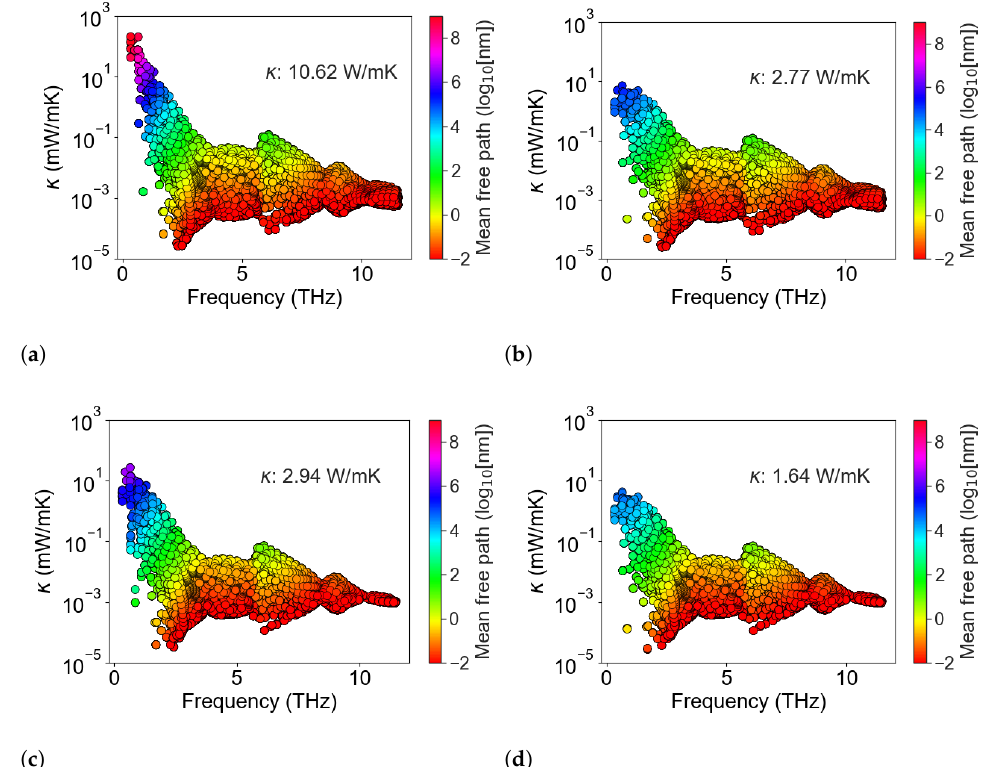
Figure 4. The per-mode thermal conductivity plotted vs. mode frequency in Si 0.8 Ge 0.2 at 300 K. Plot ( a ) shows a monolithic single crystal, ( b ) shows a bulk polycrystalline material with effective grain size of 200 nm, ( c ) shows a single crystal containing cylindrical pores with 500 nm pore spacing, and ( d ) shows the same polycrystalline materials as in ( b ) with the addition of the cylindrical pores of ( c ). For each point, the mode’s mean-free path is indicated by the marker color using a log color